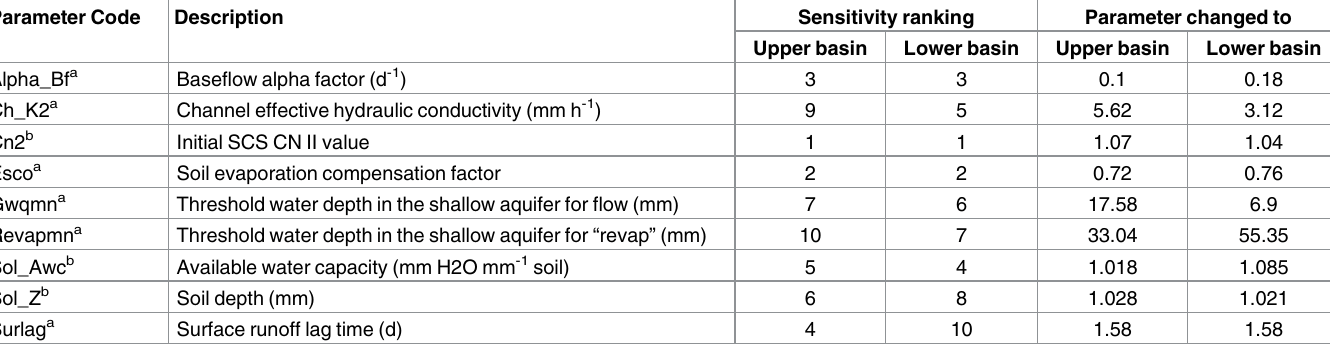
Table 2. Sensitivity analysis and final calibration results for parameters influencing predicted streamflow for the upper basin (above Enid gauge station) and lower basin (between Enid and Lovell gauge stations). Parameter